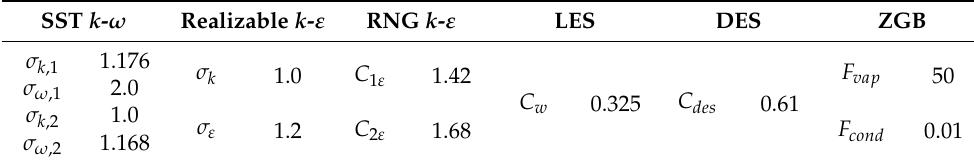
Table 2. The parameter settings for each model during numerical